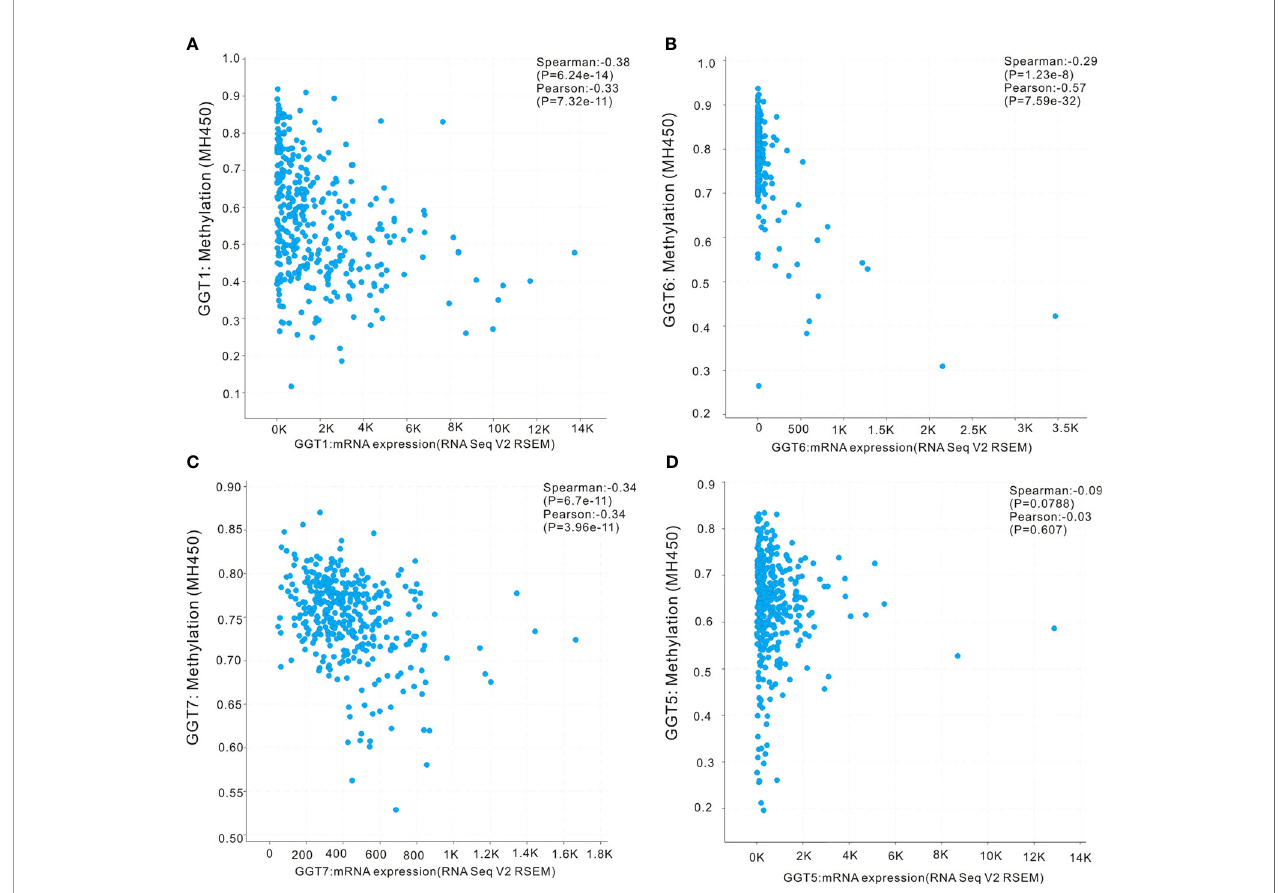
FIGURE 6 | Correlation analysis of DNA methylation with mRNA expression of GGT family members in HCC revealed by cBioPortal webpage. The negative associations between DNA methylation and expression of mRNA were observed in GGT1 (A) , GGT6 (B) , and GGT7 (C) , while this negative relationship disappeared in GGT5 (D)